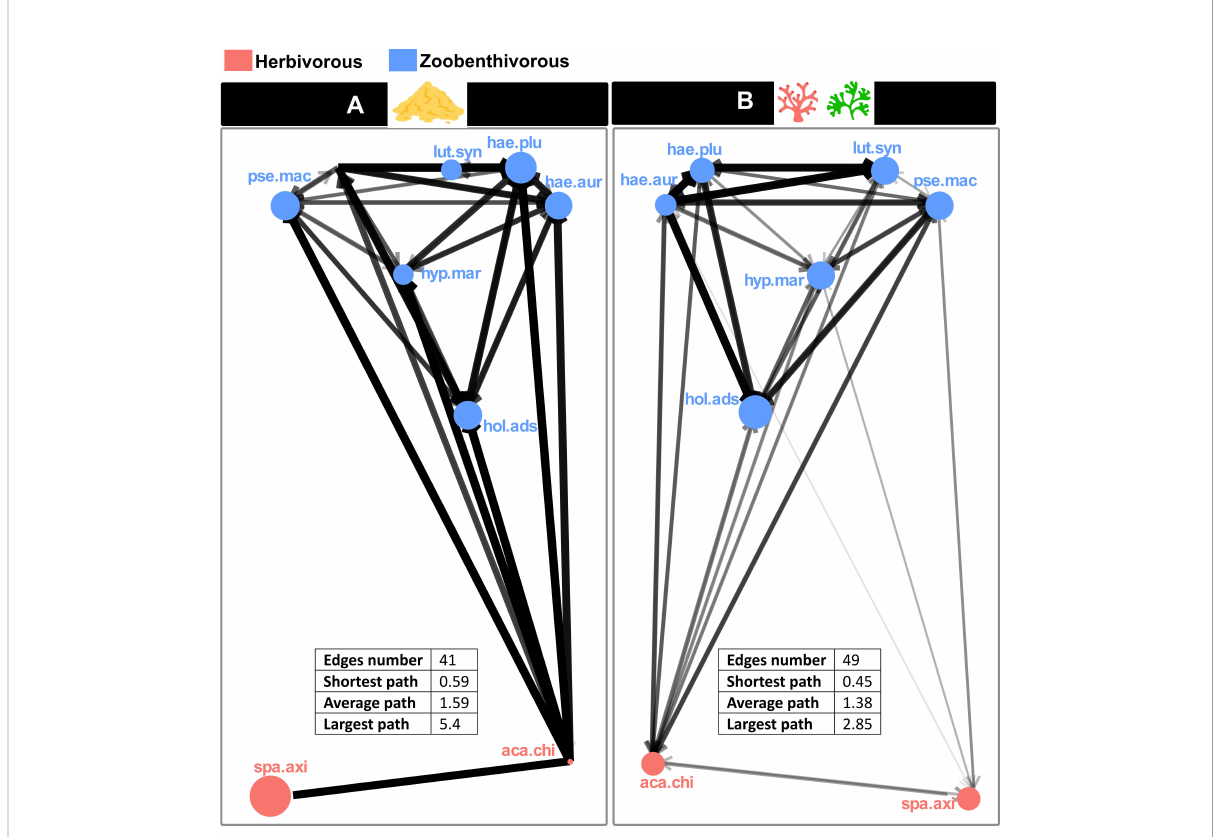
FIGURE 5 Competition networks in zones (A, B) The networks consist of nodes (one for each of the eight selected species) connected by arrows representing competitive interspeci fi c interactions. The size of the nodes was set according to intraspeci fi c competition (ITP index), and the width of the arrows was a function of the interspeci fi c index (Pov). The number of edges, shortest, largest, and average paths for each zone ’ s network are indicated. lut.syn, Lutjanus synagris ; pse.mac, Pseudopenneus maculatus ; hae.plu, Haemulon plumierii ; hae.aur, Haemulon aurolineatum ; hyp.mar, Hypanus marianae ; hol.ads, Holocentrus adscencionis ; aca.chi, Acanthurus chirurgus; spa.axi, Sparisoma axillare